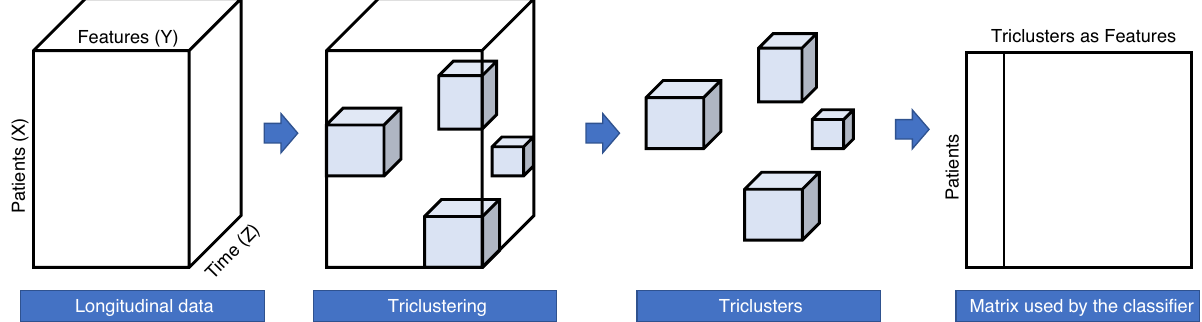
Figure 5. Overview of triclustering-based classifier applied to ALS case study. Three-way data corresponds to longitudinal data collected at patients’ follow-up, and in particular, the dimensions X, Y, and Z correspond to patients, features and time.